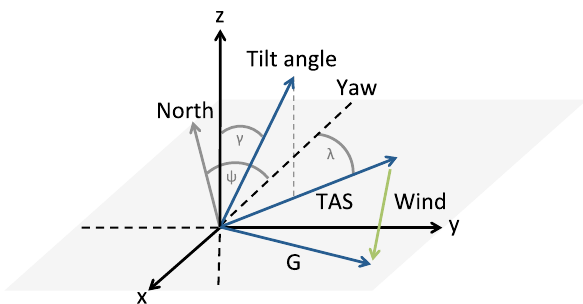
Figure 3. Relationship between the tilt angle γ of the multicopter and the wind triangle with true air speed (TAS) vector, ground (G) vector and wind vector. Pitch angle is in x axis and roll angle in y axis direction. Yaw ( ψ ) is the viewing direction of the multicopter relative to north and the angle between TAS and yaw is λ